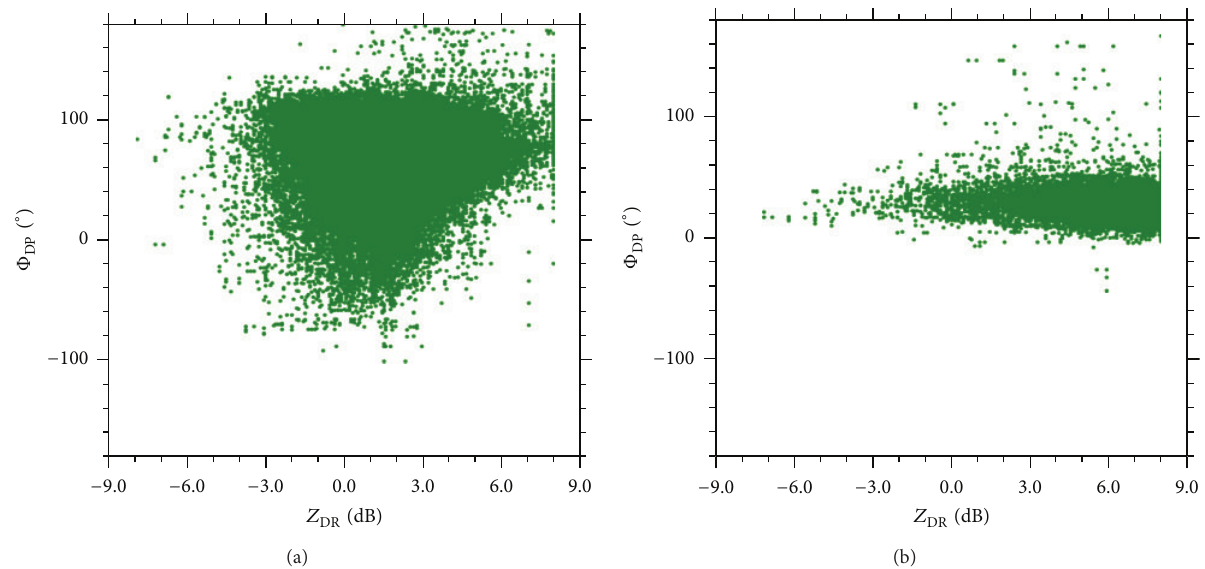
Figure 2: 𝑍 – Φ scattergrams for BS pixels identified by the simplified HCA from the KVNX 0.5 ∘ scans at (a) 0706 UTC (local midnight) DR DP and (b) 1901 UCT (local midday), respectively, on 17 October 2011.